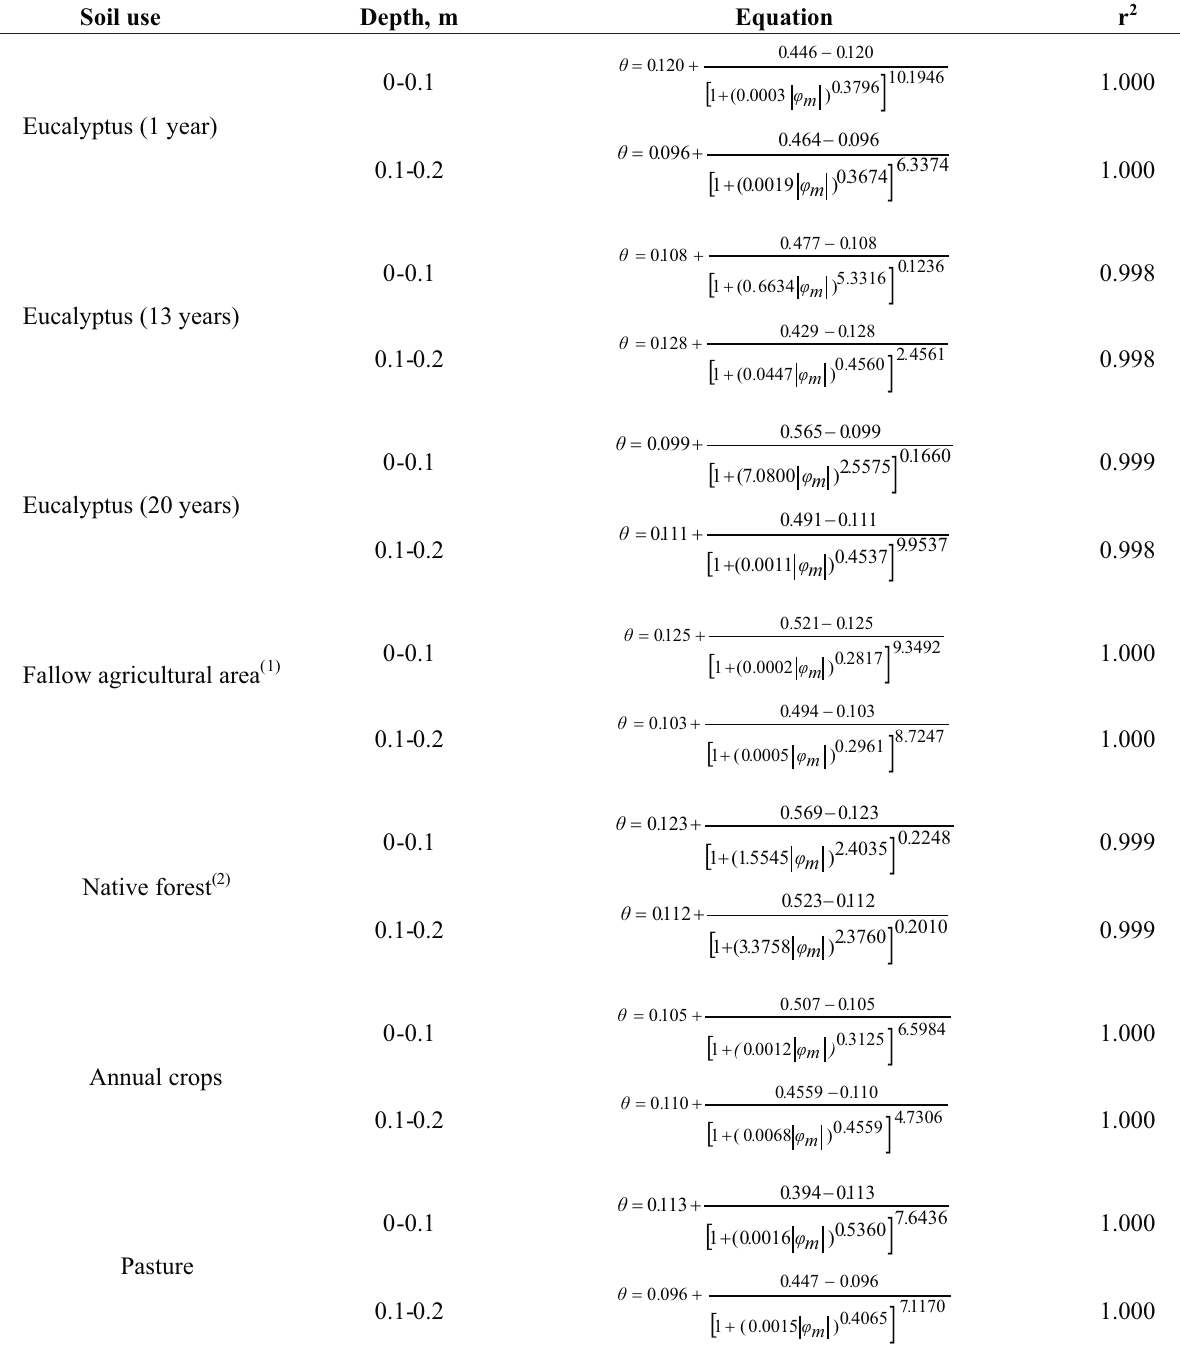
Table 3. Equations adjusted, with determination coefficients, to the soil water retention curves to obtain water